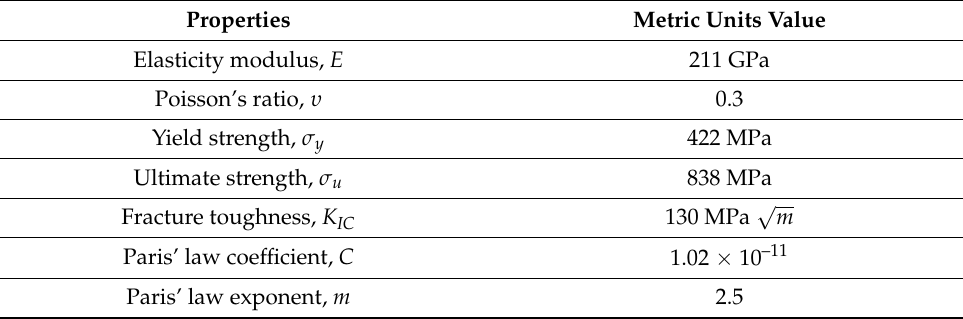
X Origin of the referential system Y Figure 2. Modified compact tension geometrical dimensions. Figure 2. Modified compact tension geometrical dimensions. Table 1. Mechanical properties of the nickel-based superalloy